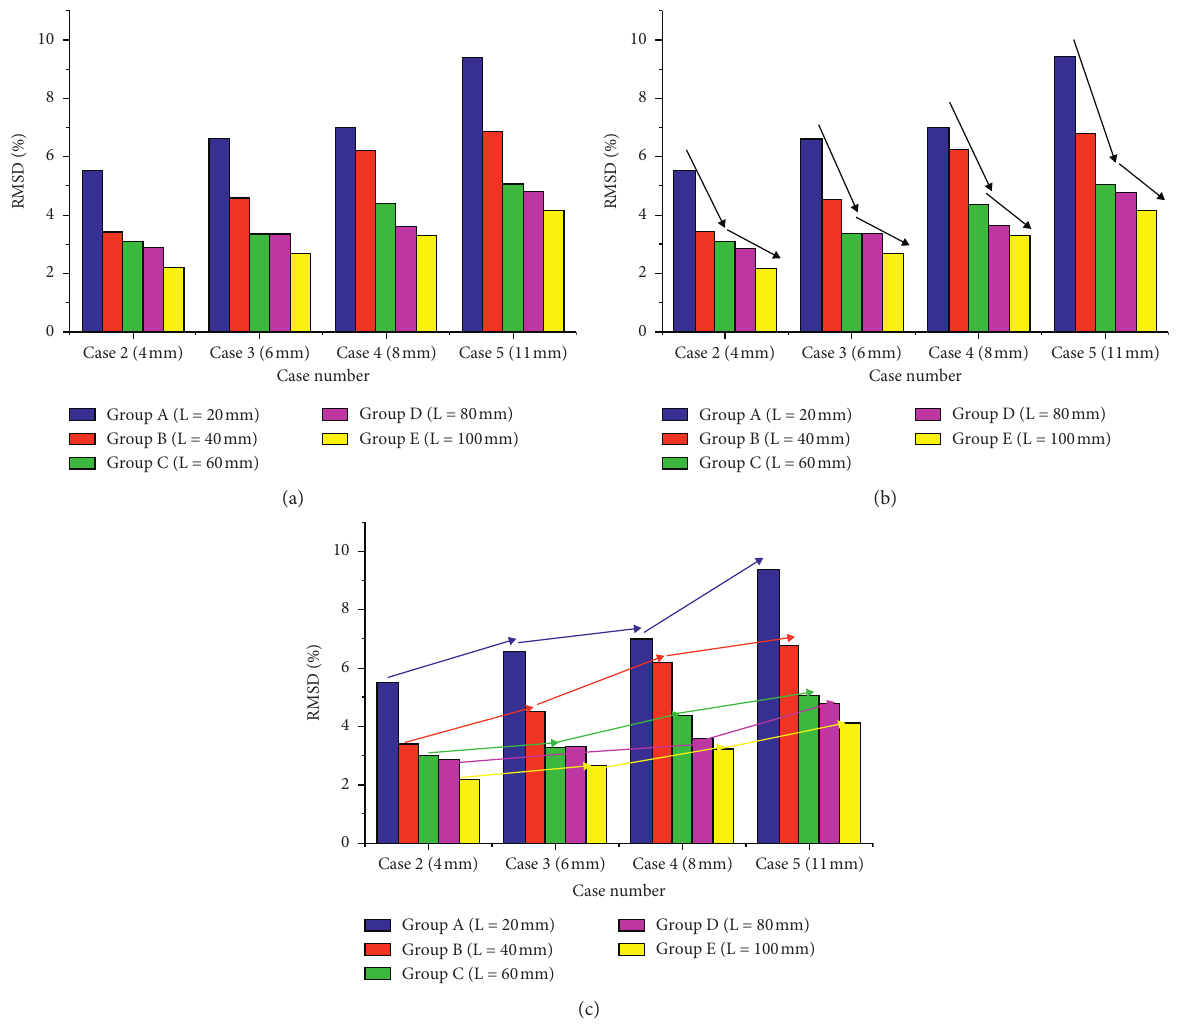
Figure 8: The variation of damage index RMSD with different damaged cases. (a)The variation of RMSD in different cases. (b) The variation tendency of RMSD with damage location. (c)The variation tendency of RMSD with damage